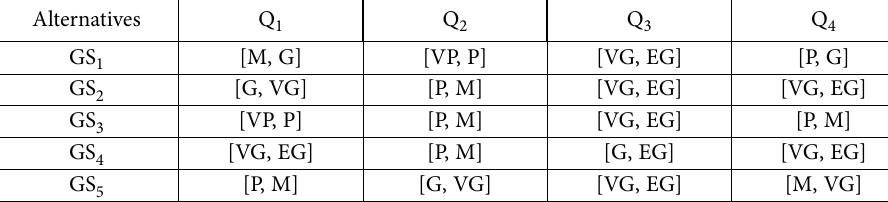
Table 9. The ULTSs through DM 4 Alternatives